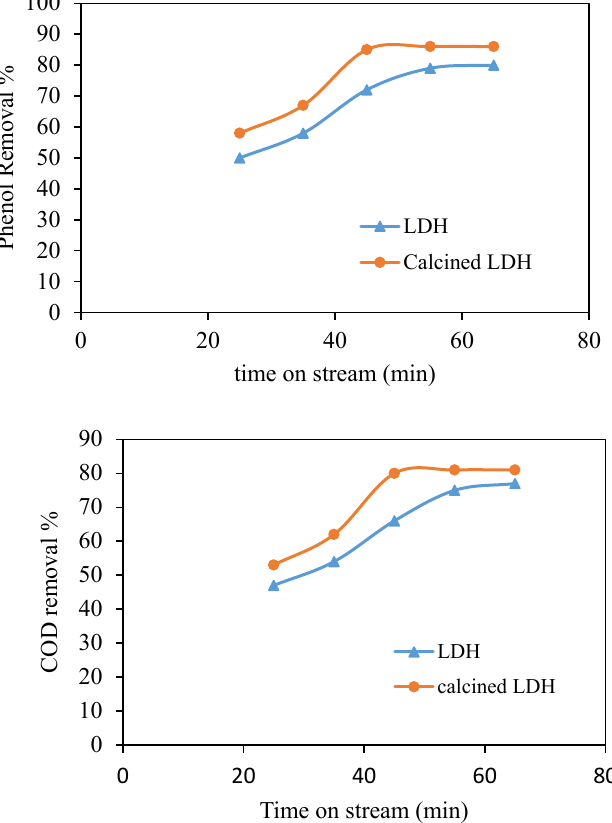
Fig.8. Phenol removal and COD removal percent at different times on stream over Mg-Al LDH and calcined LDH (reaction conditions: V = 100 mL, m = 0.05 g, initial phenol concentration: 100 mg L -1 , V